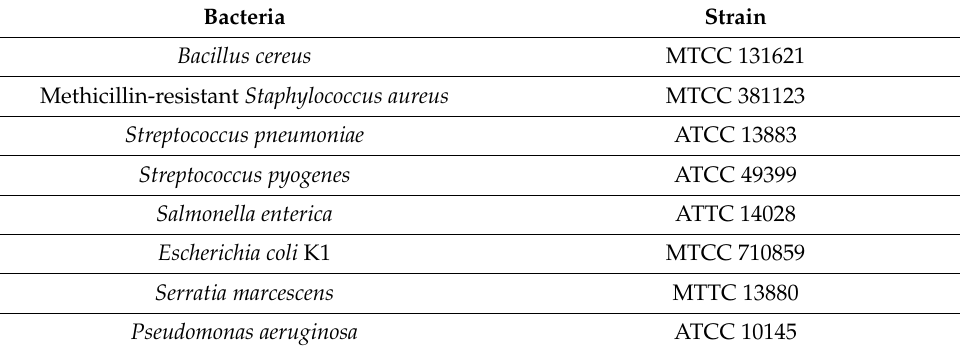
Table 1. Bacteria used in the study.